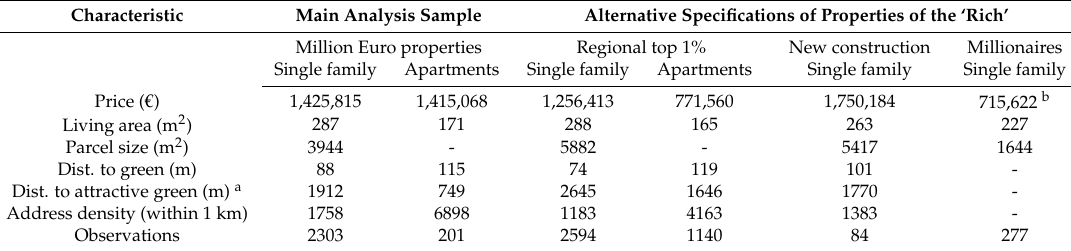
Table 4. Sample means for alternative